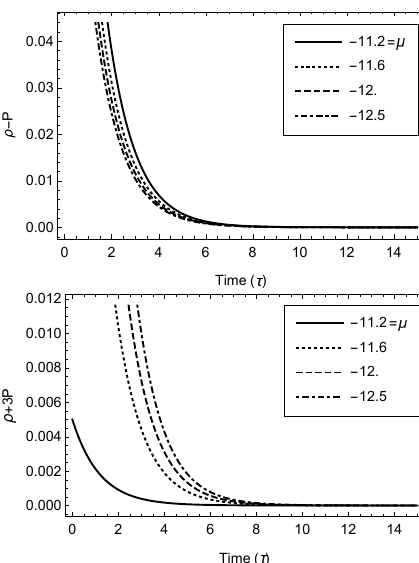
Figure 2. Variation of (a) ρ − P , (b) ρ + P , and (c) ρ + 3 P w.r.t. time (Case 3.1).